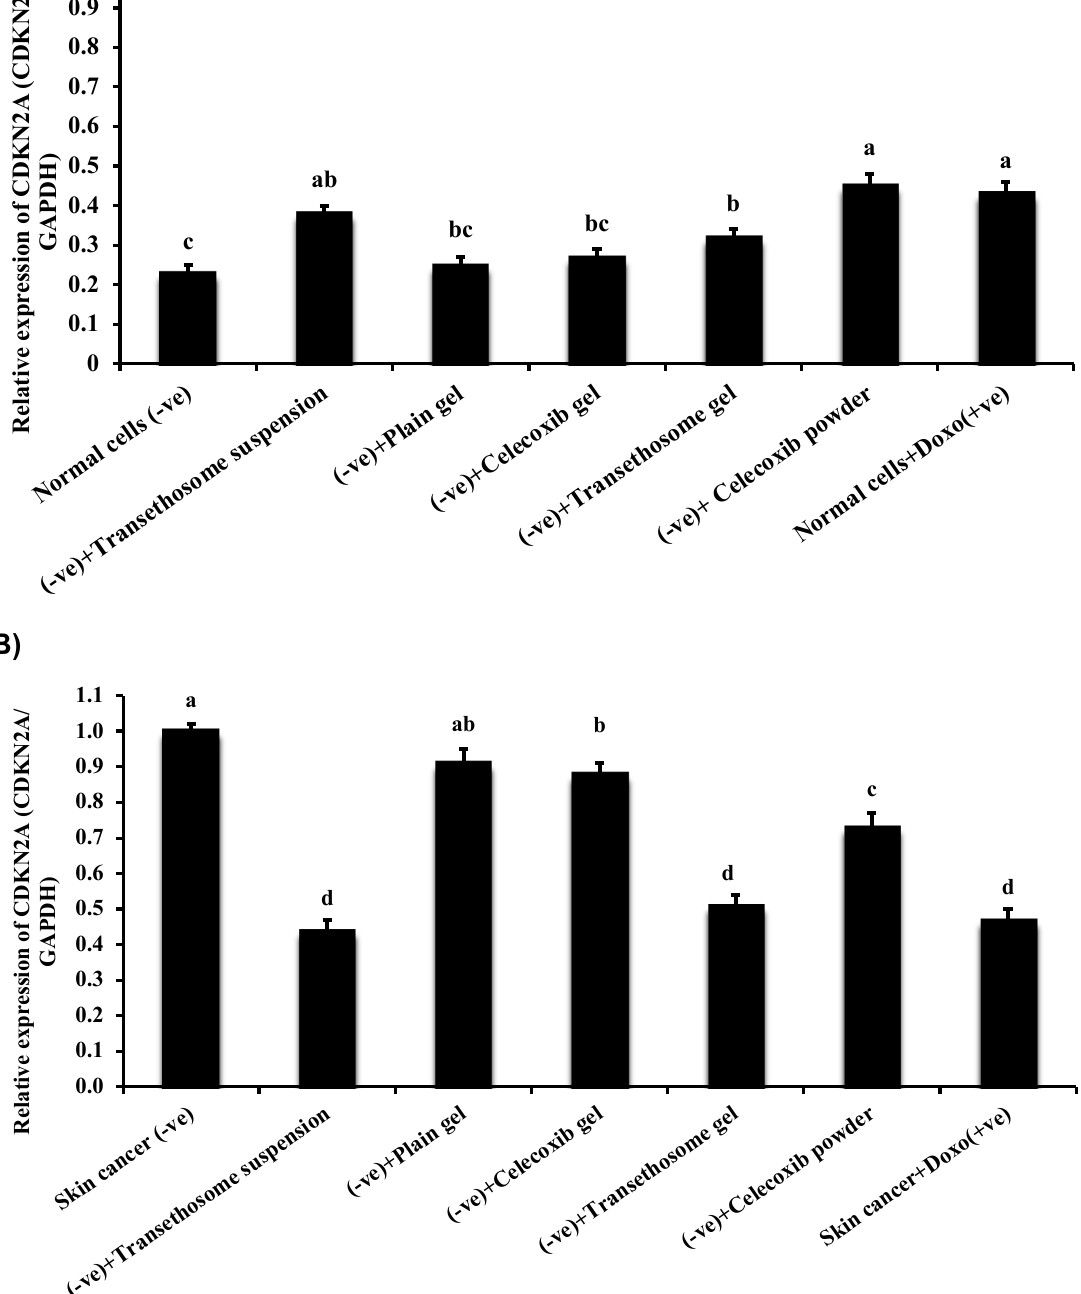
Figure 6. ( A ) The alterations of CDKN2A gene in normal skin cell lines treated with different CXB preparations. ( B ) The alterations of CDKN2A gene in skin cancer cell line lines treated with different CXB preparations. Data are presented as mean ± SD. a,b,c,d : Mean values within tissue with unlike superscript letters were significantly different ( p ≤ 0.05; ANOVA/Tukey).